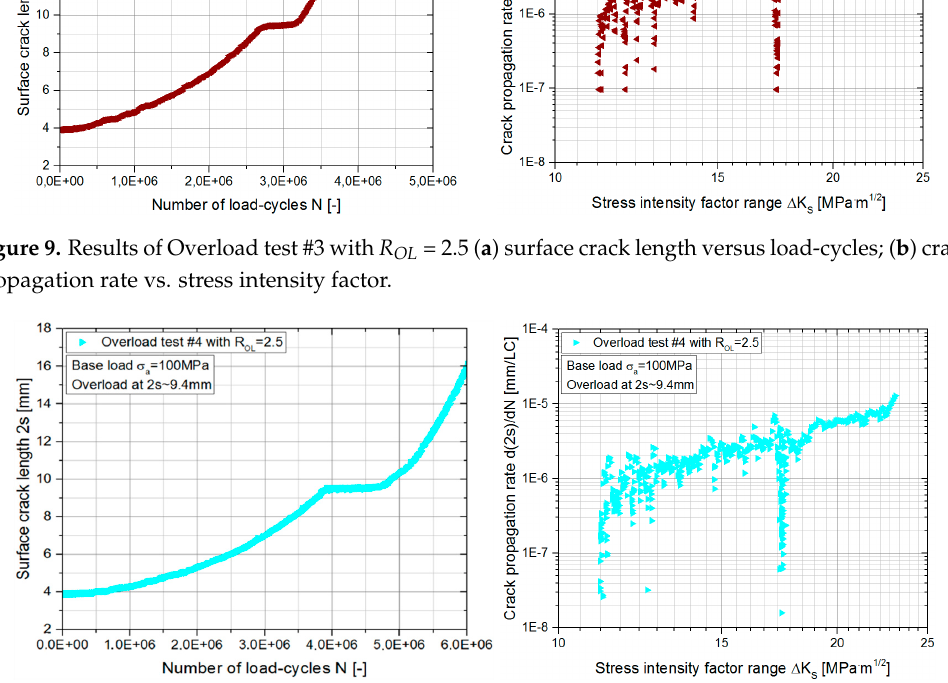
Figure 10. Results of Overload test #4 with R OL = 2.5 ( a ) surface crack length versus load-cycles; ( b ) crack propagation rate vs. stress intensity factor.